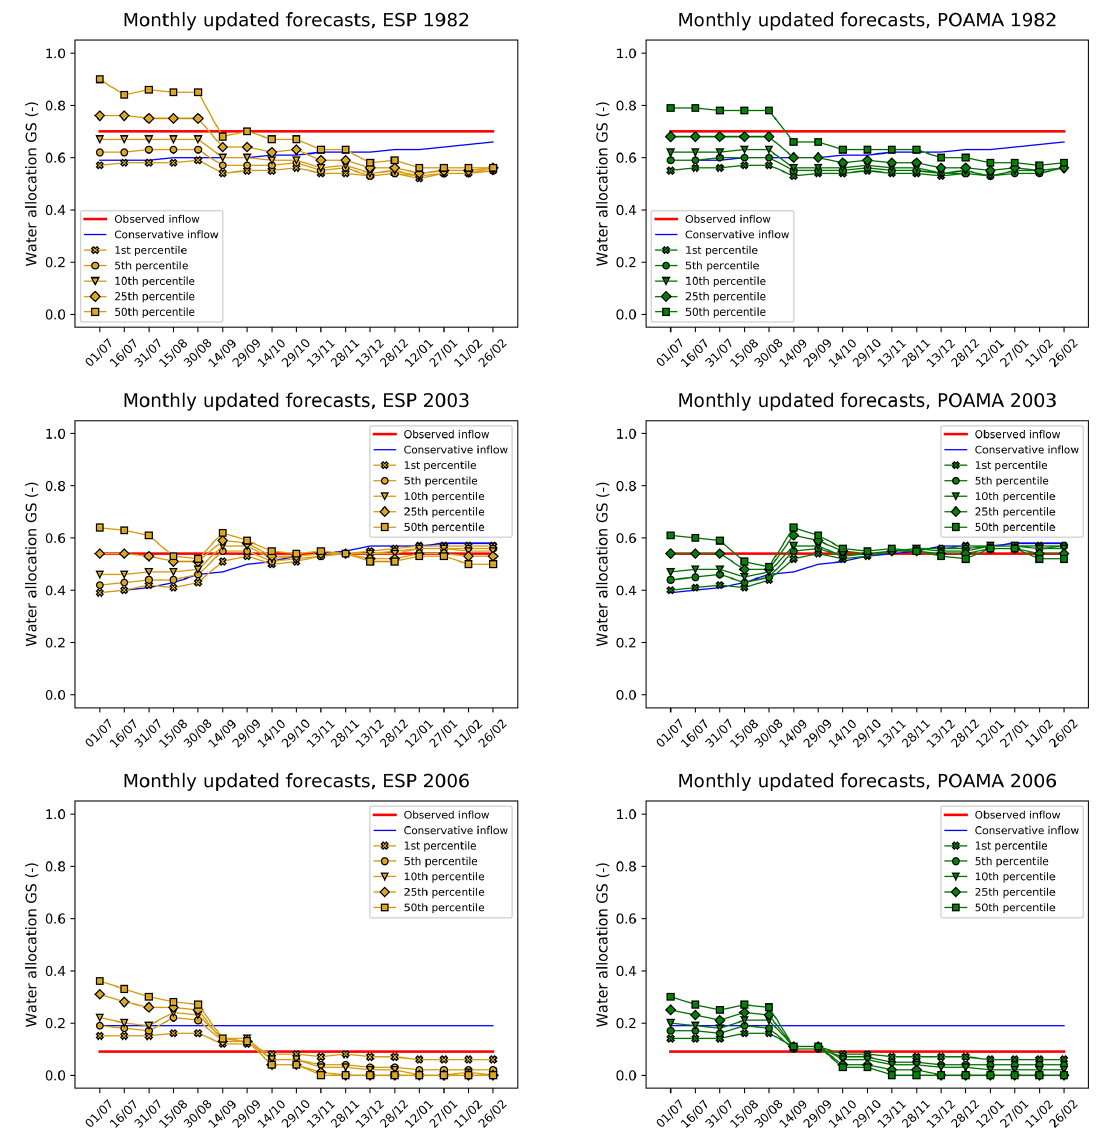
Figure 9. Water allocation GS for selected dry years (1982, 2003, and 2006) using new inflow predictions every month (monthly updated